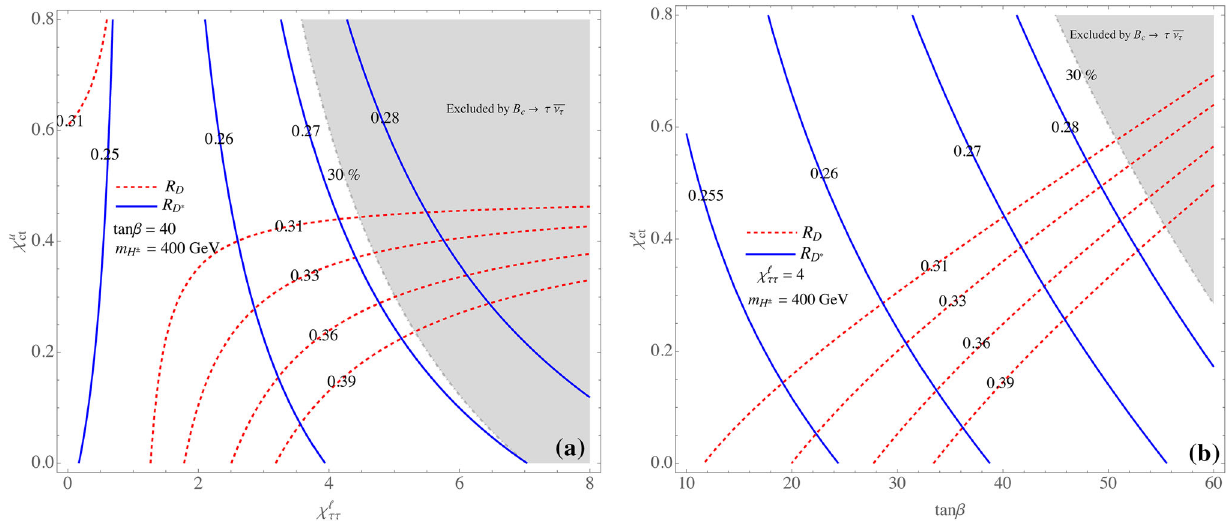
Fig. 2 The legend is the same as that in Fig. 1, and the upper limit of BR ( B c → τ ¯ ν τ ) < 30% is included